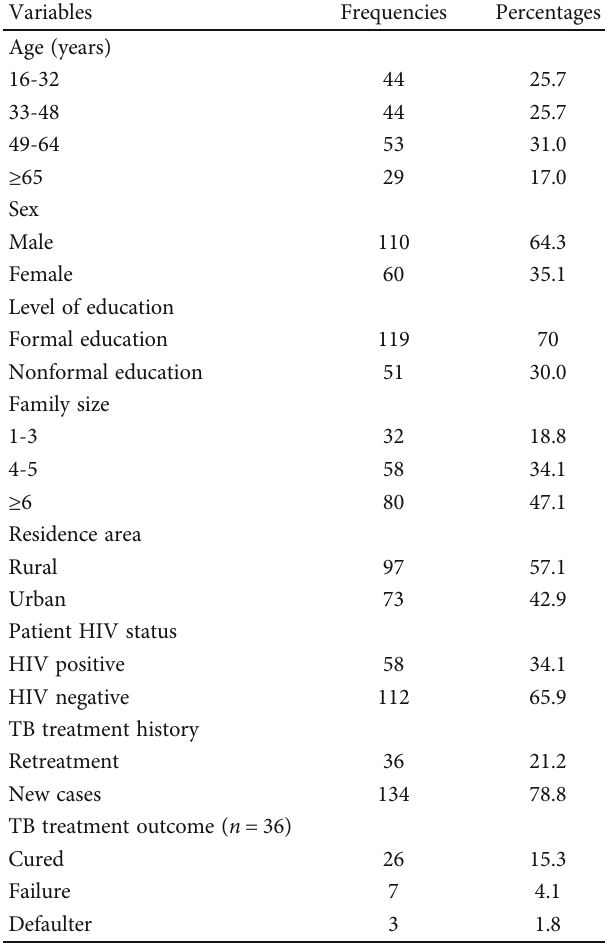
Table 1: Sociodemographic and clinical characteristics of study participants at Enat Hospital, Merhabete district, Central Ethiopia, 2020 ( N = 170